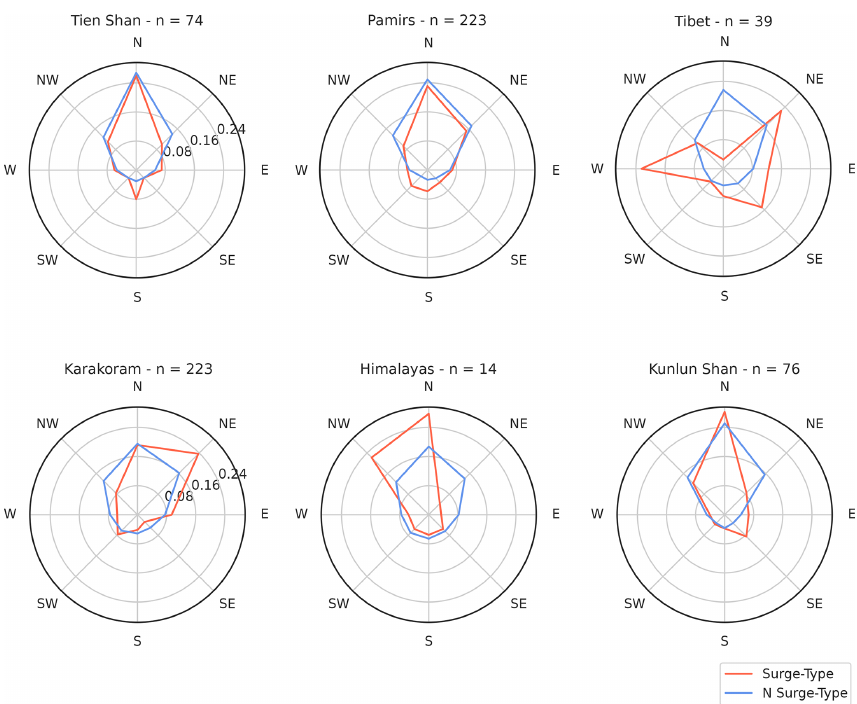
Figure 7. Aspect sector distribution for surging and non-surge-type glaciers for each greater study region per count. n refers to the number of surge-type glaciers per greater HIMAP region.